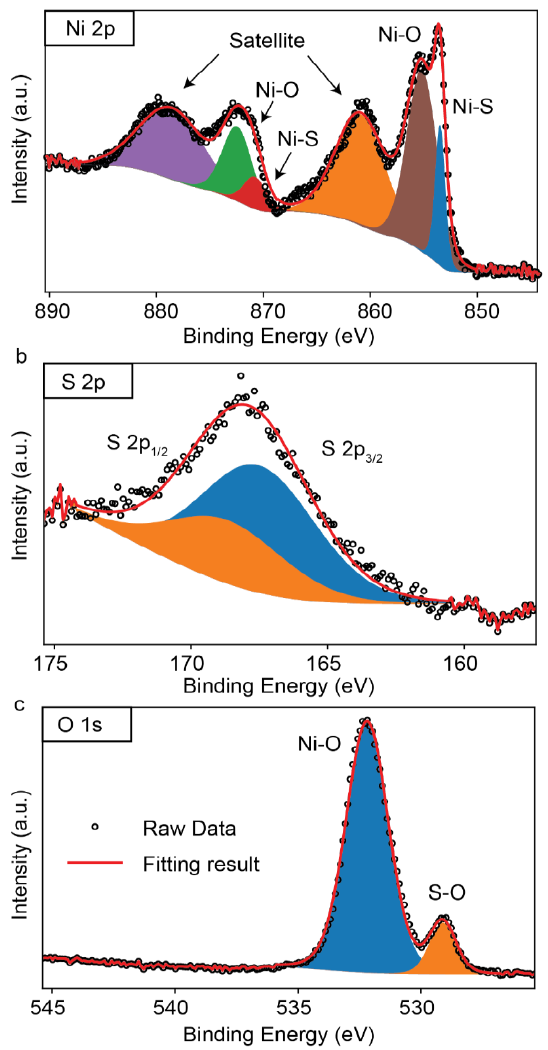
Figure 2. XPS measurement for nickel oxysulfide of ( a ) Ni 2p, ( b ) S 2p, and ( c ) O 1s spectrum.